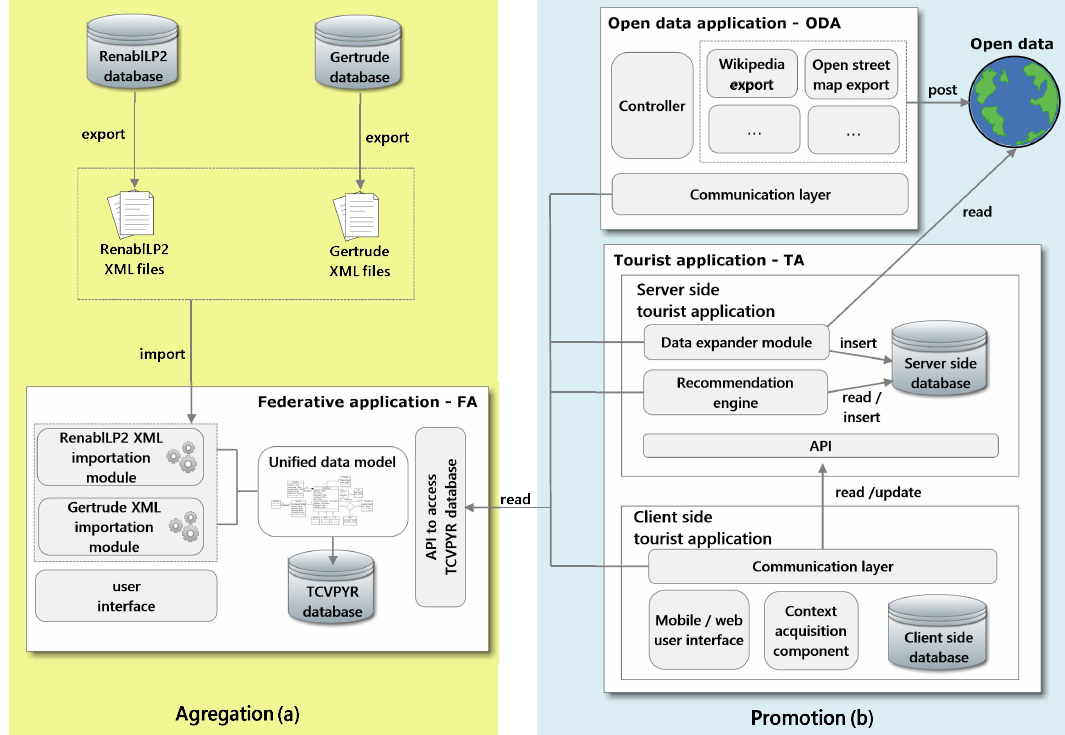
Figure 1. Overview of the architecture of our proposed